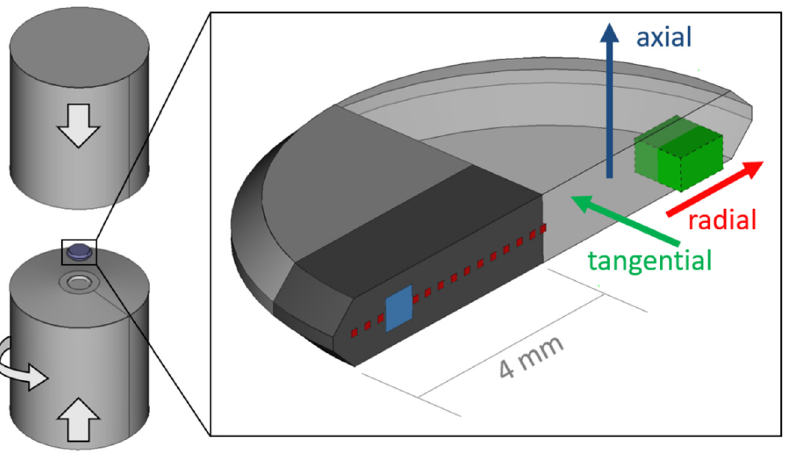
Figure 1. Schematic representation of the HPT-setup consisting of two anvils and the sample whereat a halved HPT-disc is shown in more detail. The position and size of a SQUID specimen is highlighted in green. Respective HPT-deformation directions are shown as coloured arrows. SEM measurements are conducted in a tangential direction at a radius ≈ 3 mm as highlighted in blue. Radially resolved HEXRD texture analysis is performed on a specimen (dark grey) in a tangential direction (red areas) in transmission mode.